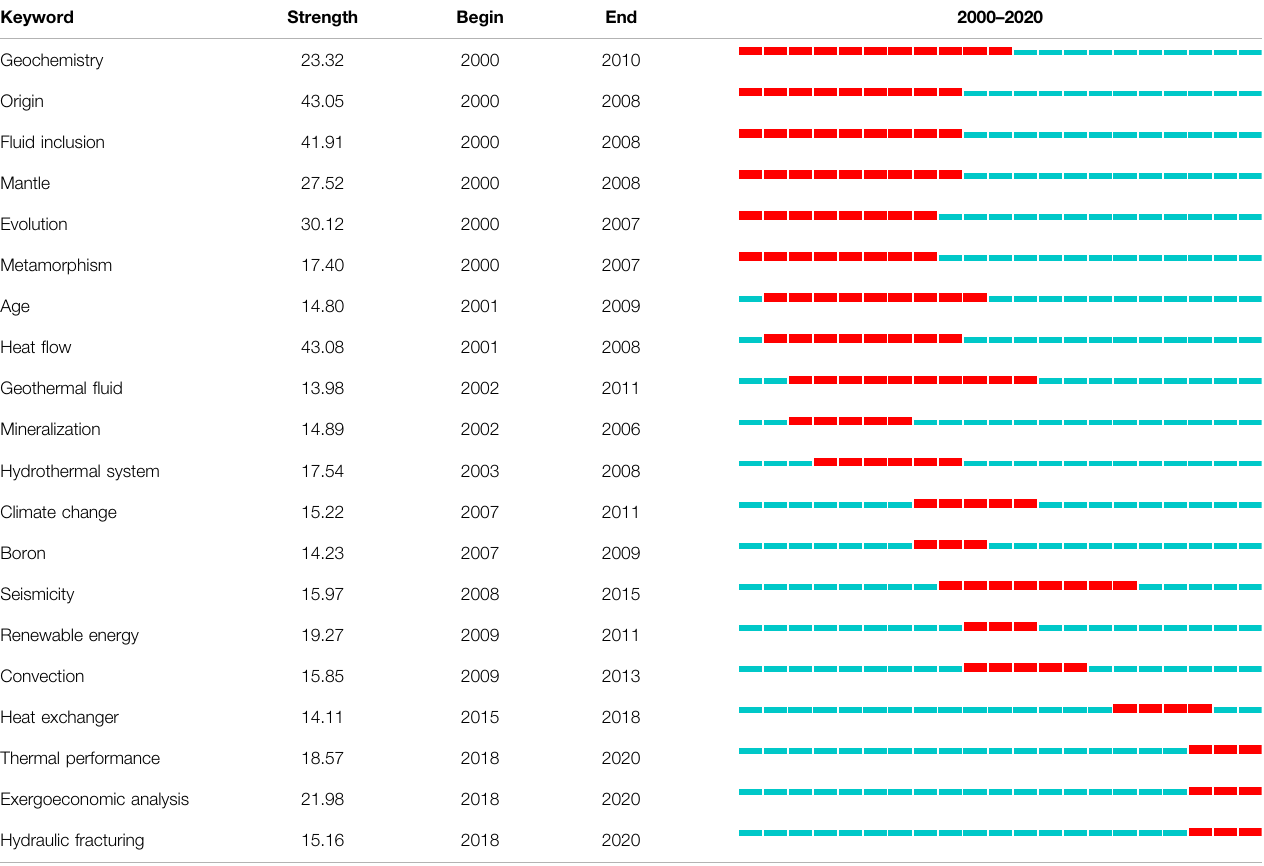
TABLE 3 | Burst term information of